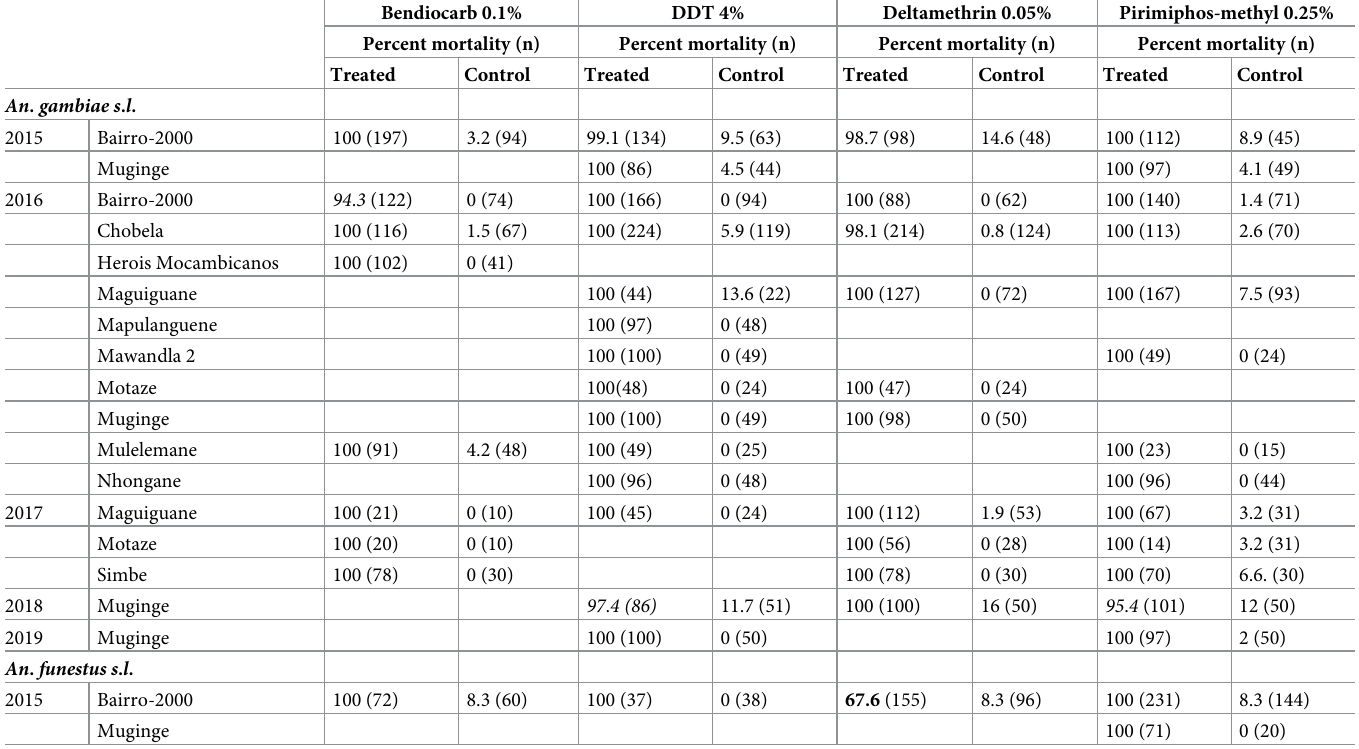
Table 2. Insecticide susceptibility of F1 generation An . funestus s . l . and An . gambiae s . l . from Magude district, 2015–2018. Italics are used to indicate suspected resis- tance (mortality 90–97%); bold numbers indicate confirmed resistance (mortality below